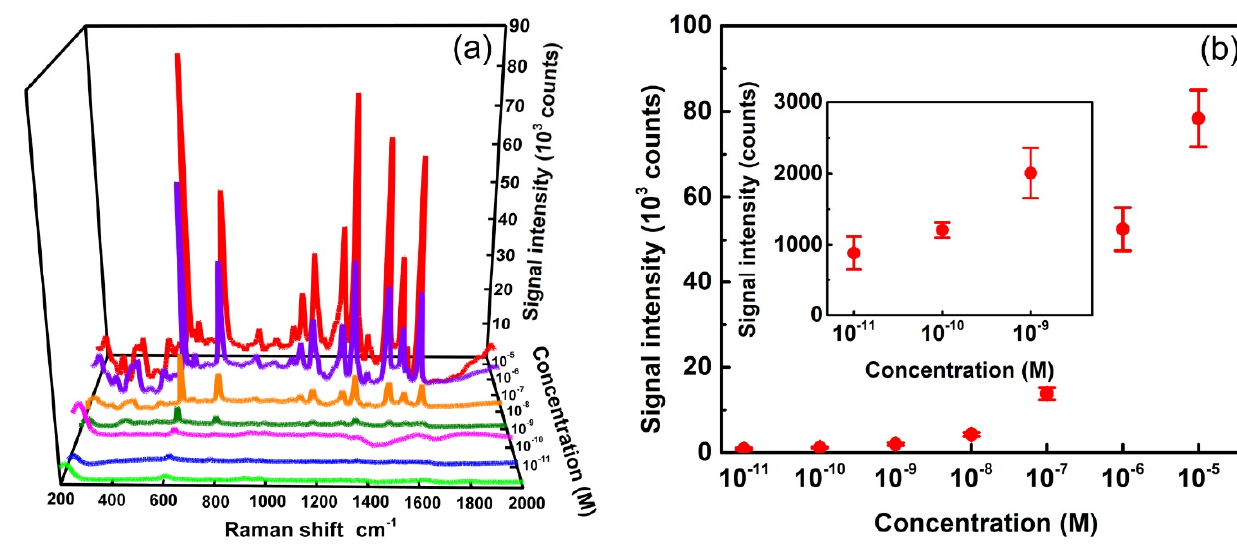
Figure 6. ( a ) SERS spectra of R6G with concentrations from 10 − 5 M to 10 − 11 M on Ag-AAO substrates. The spectra are pristine with neither intensity shift nor background subtraction. ( b ) SERS signal intensity at 613 cm − 1 as a function of the R6G concentration. The laser wavelength of 532 nm, objective lens of 10×, and exposure times of 3 s were used for the measurement. Inset shows a zoomed-in area of the plot from concentrations between 10 − 11 M and 10 − 9 M.